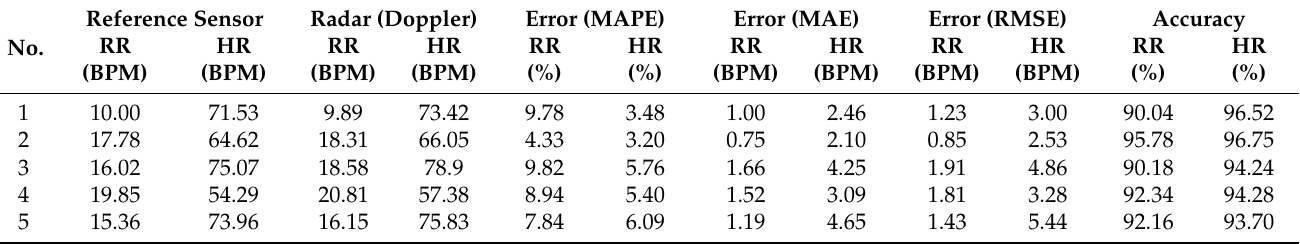
Table 6. The measurement accuracy of respiration and heartrates monitored by the FMCW radar with beamforming for the case with